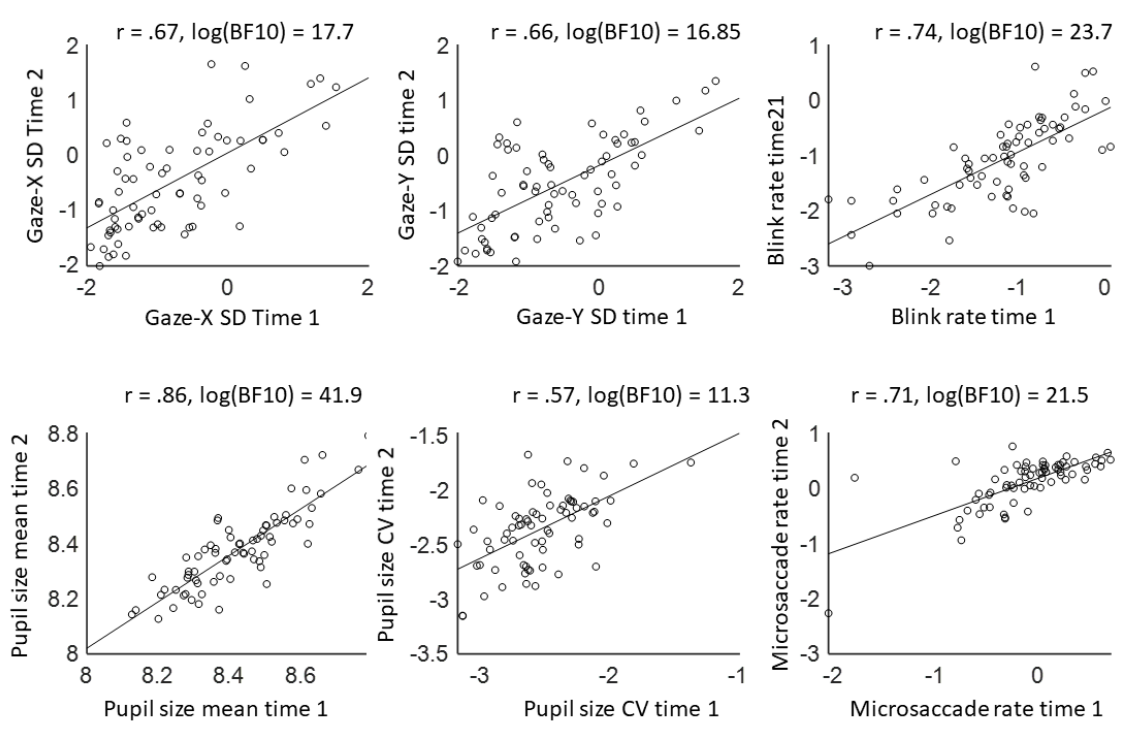
Figure 3. Correlations between time point 1 (pre-task) and time point 2 (post-task) for each of the five oculomotor measures from Experiment 1: Gaze variability (standard deviation; SD) in the horizontal dimension, gaze SD in the vertical dimension, pupil size mean, pupil size coefficient of variability (CV), blink rate per second, and microsaccade rate per second (Ms). All five measures show a high correlation coefficient and accompanying high Bayes Factor, indicating that the measures show intra-individual reliabil- ity over time. Note that both the measures and the Bayes Factors are